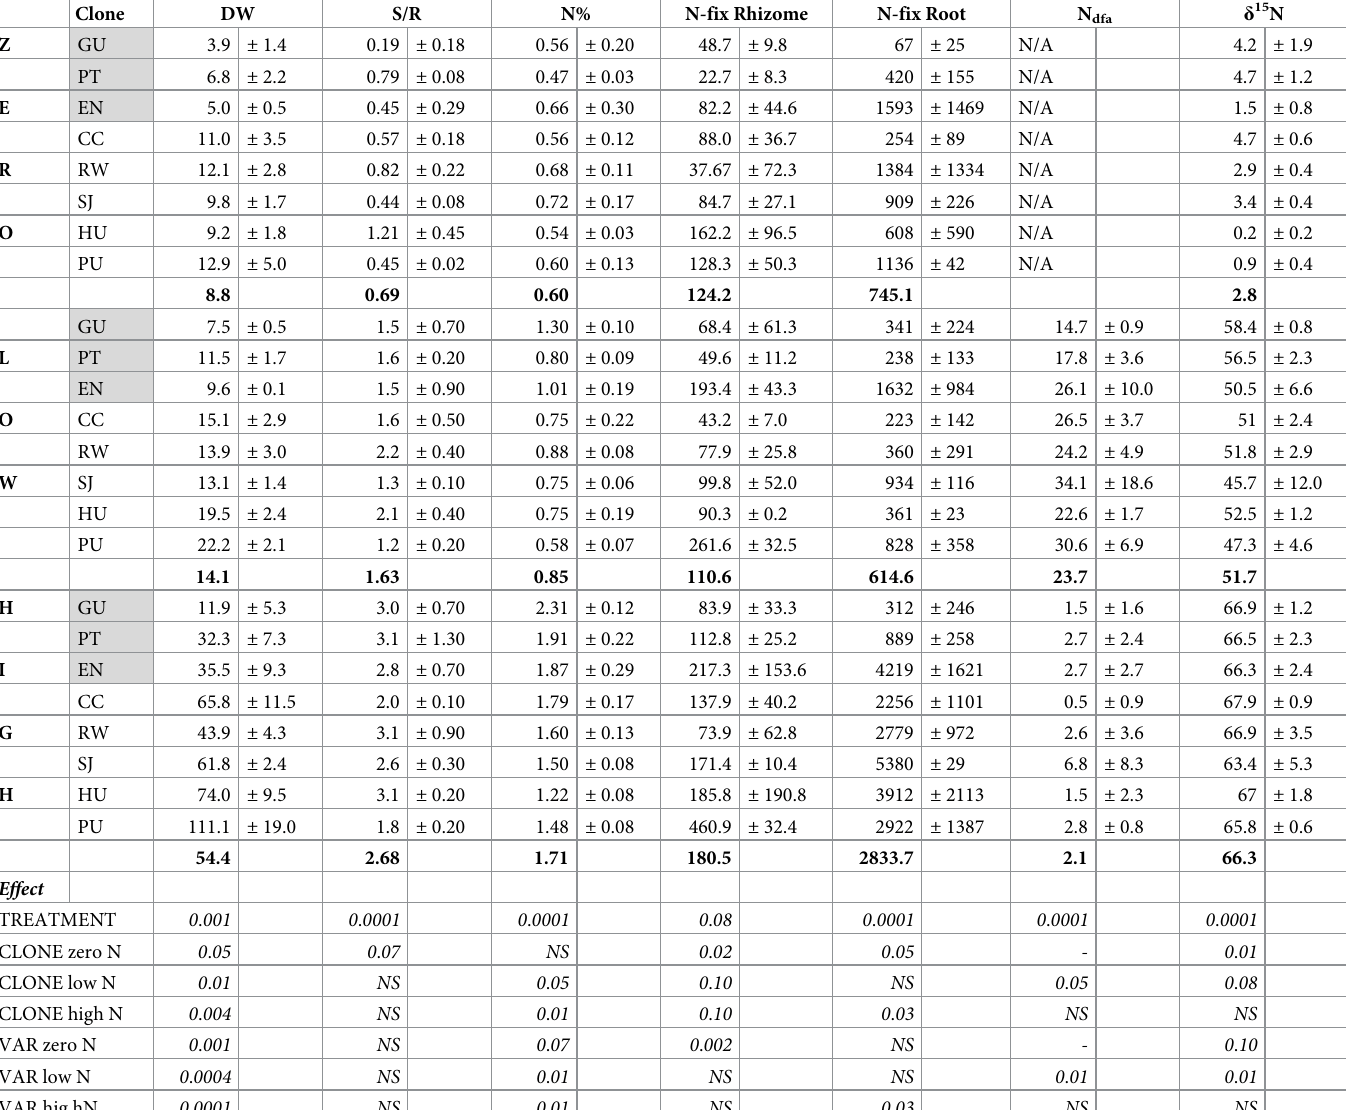
Table 6. Means ± standard deviations of response variables of Schoenoplectuscalifornicus to nitrogen